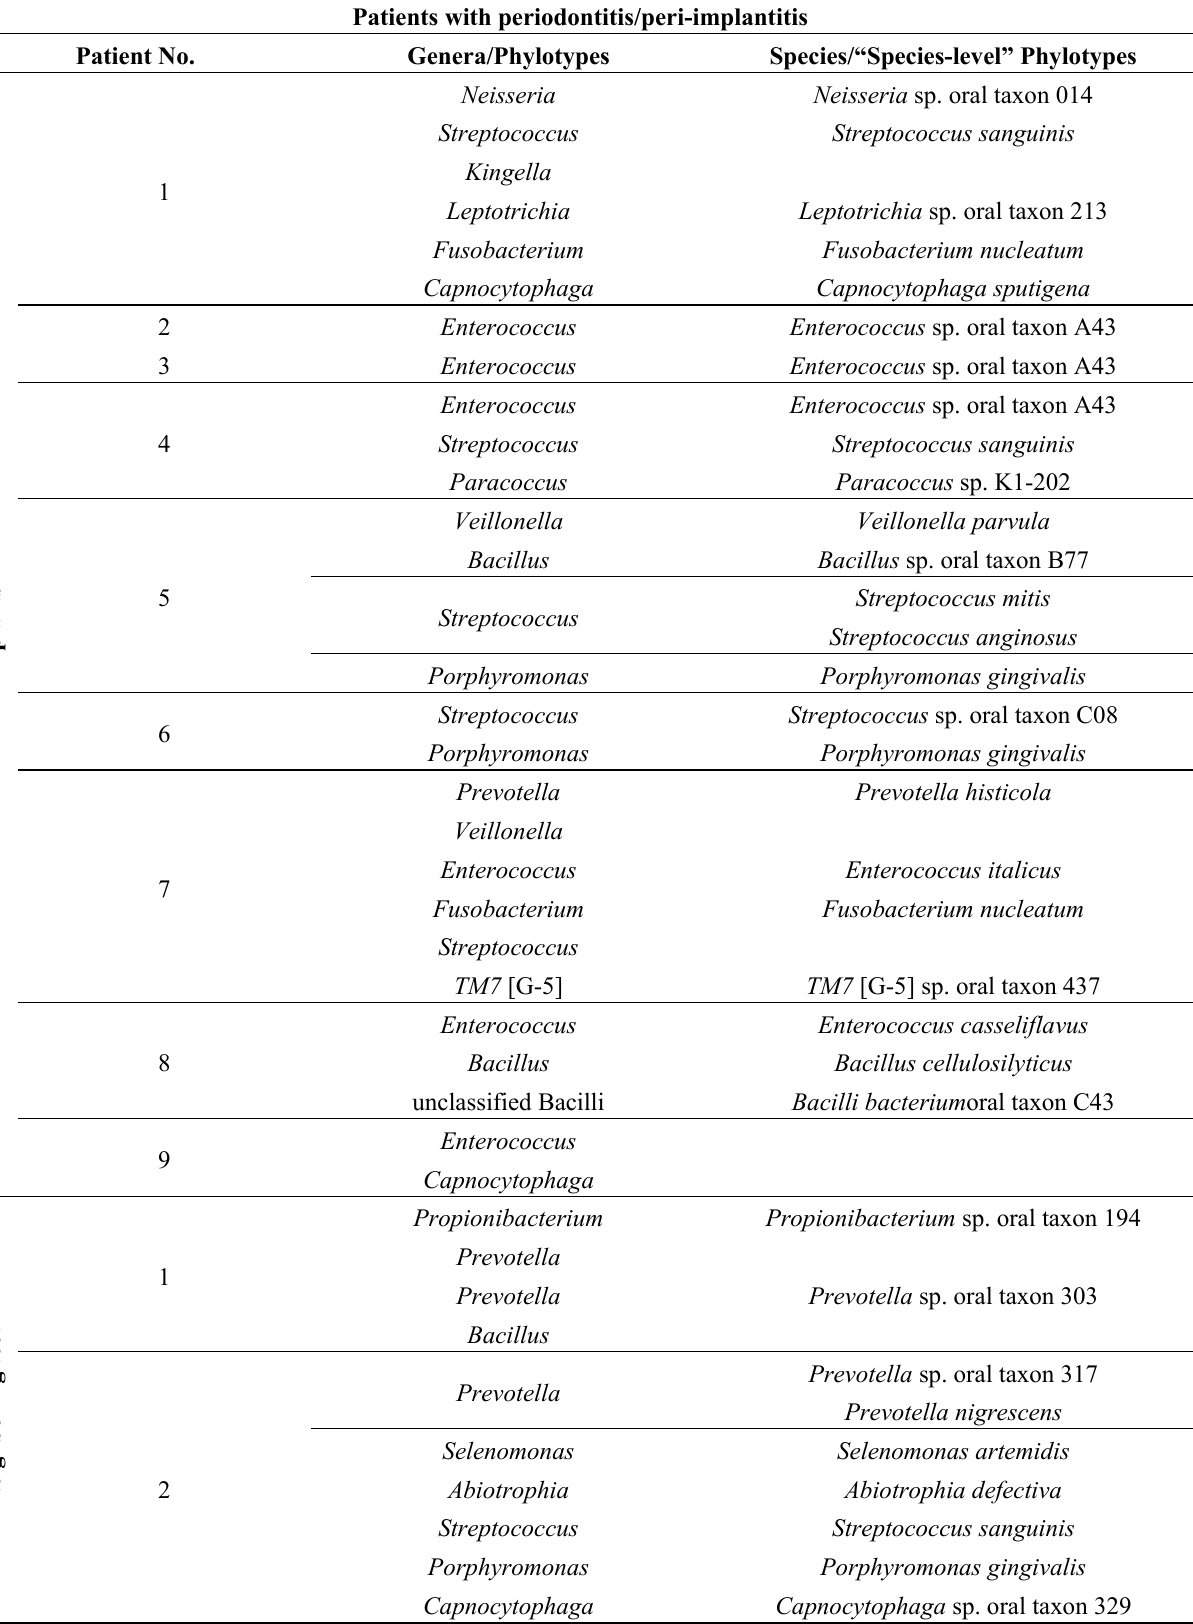
Table 5. Results on species-level or species-level phylotype in the diseased and healthy groups at different sampling points. Patients with periodontitis/peri-implantitis Patient